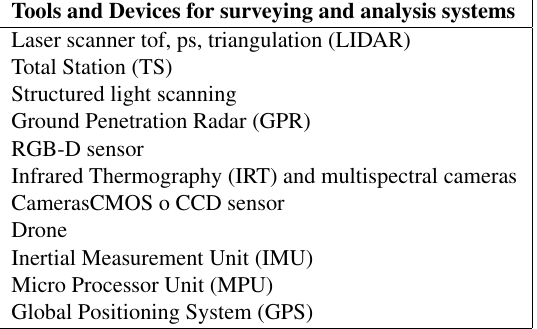
Table 1: Available tools in AAH survey field